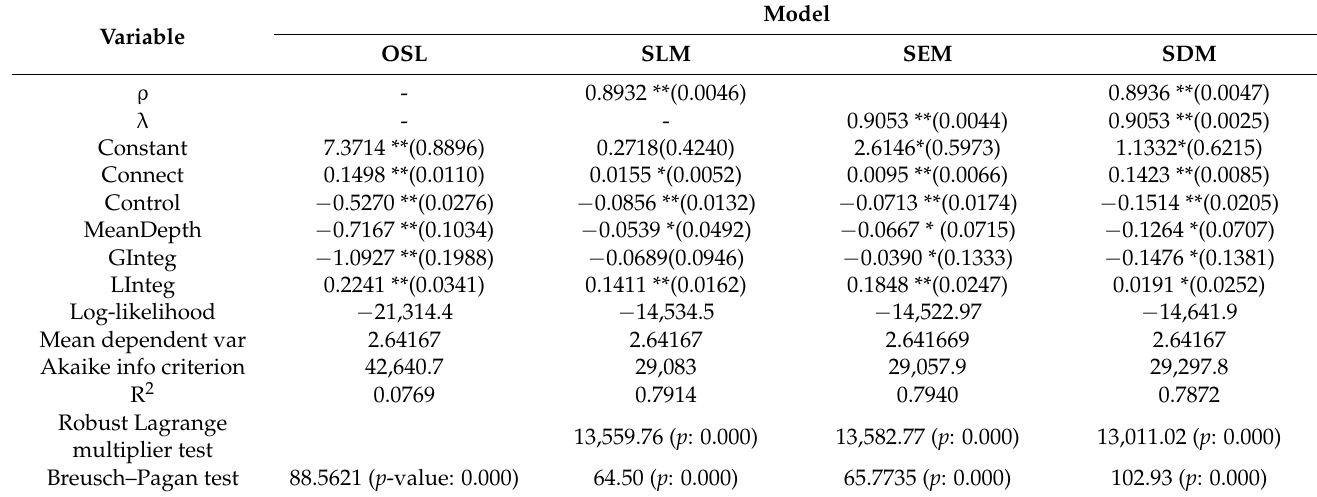
Table 4. Workday spatial autocorrelation regression